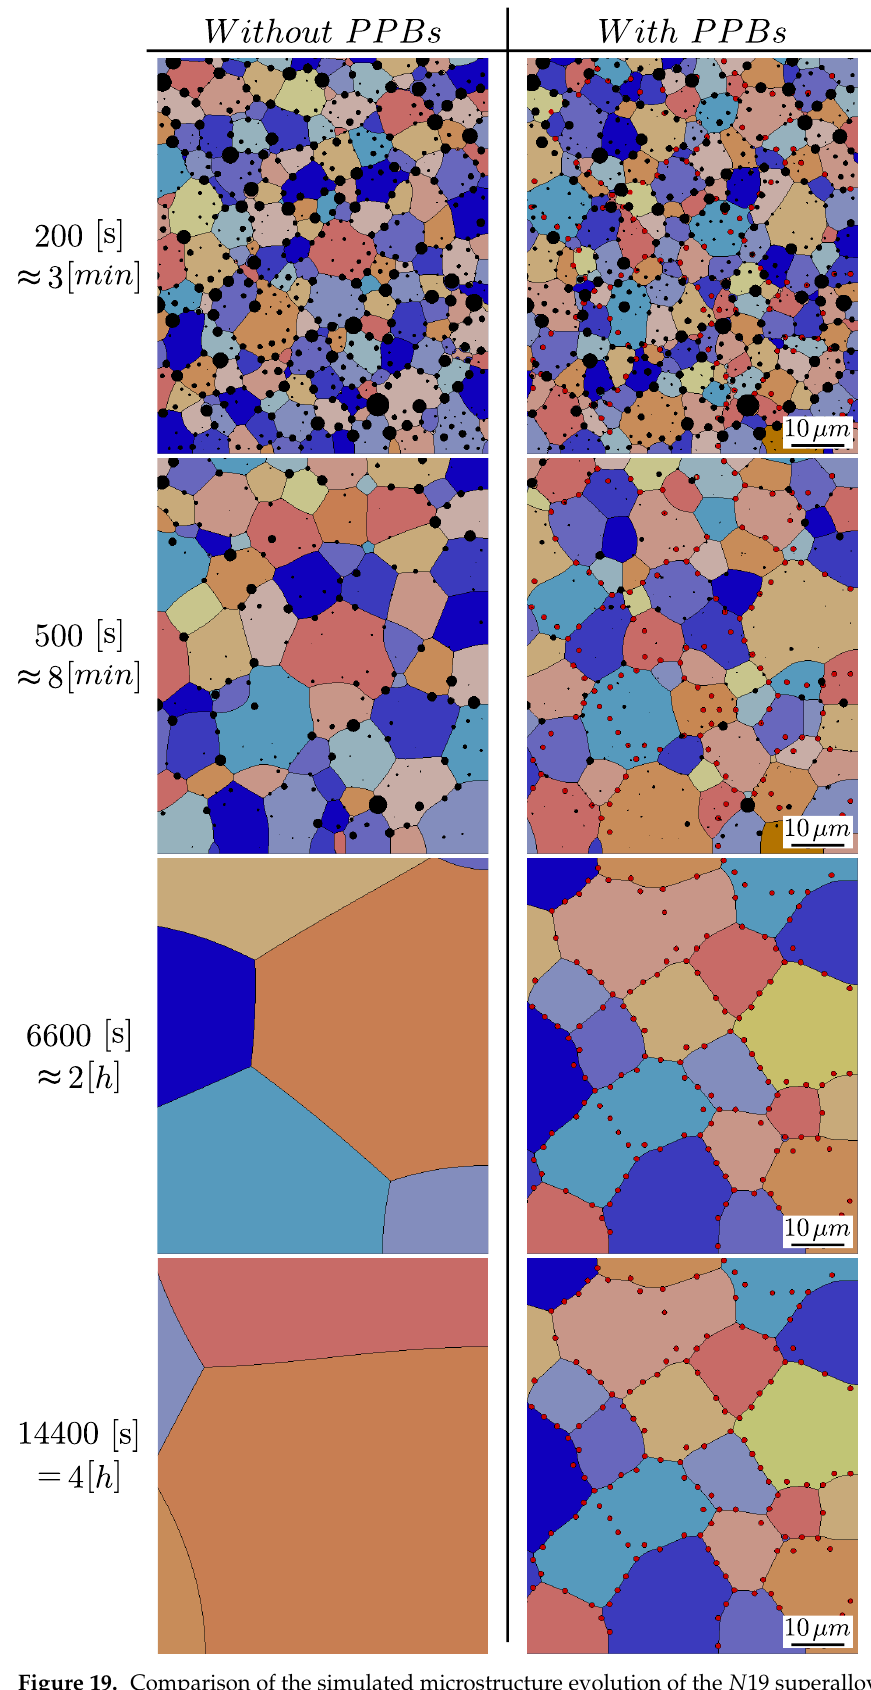
Figure 19. Comparison of the simulated microstructure evolution of the N 19 superalloy considering or not the PPB particles (red) at 1150 ◦ C for a zoomed area of the 0.5 mm × 0.5 mm simulation